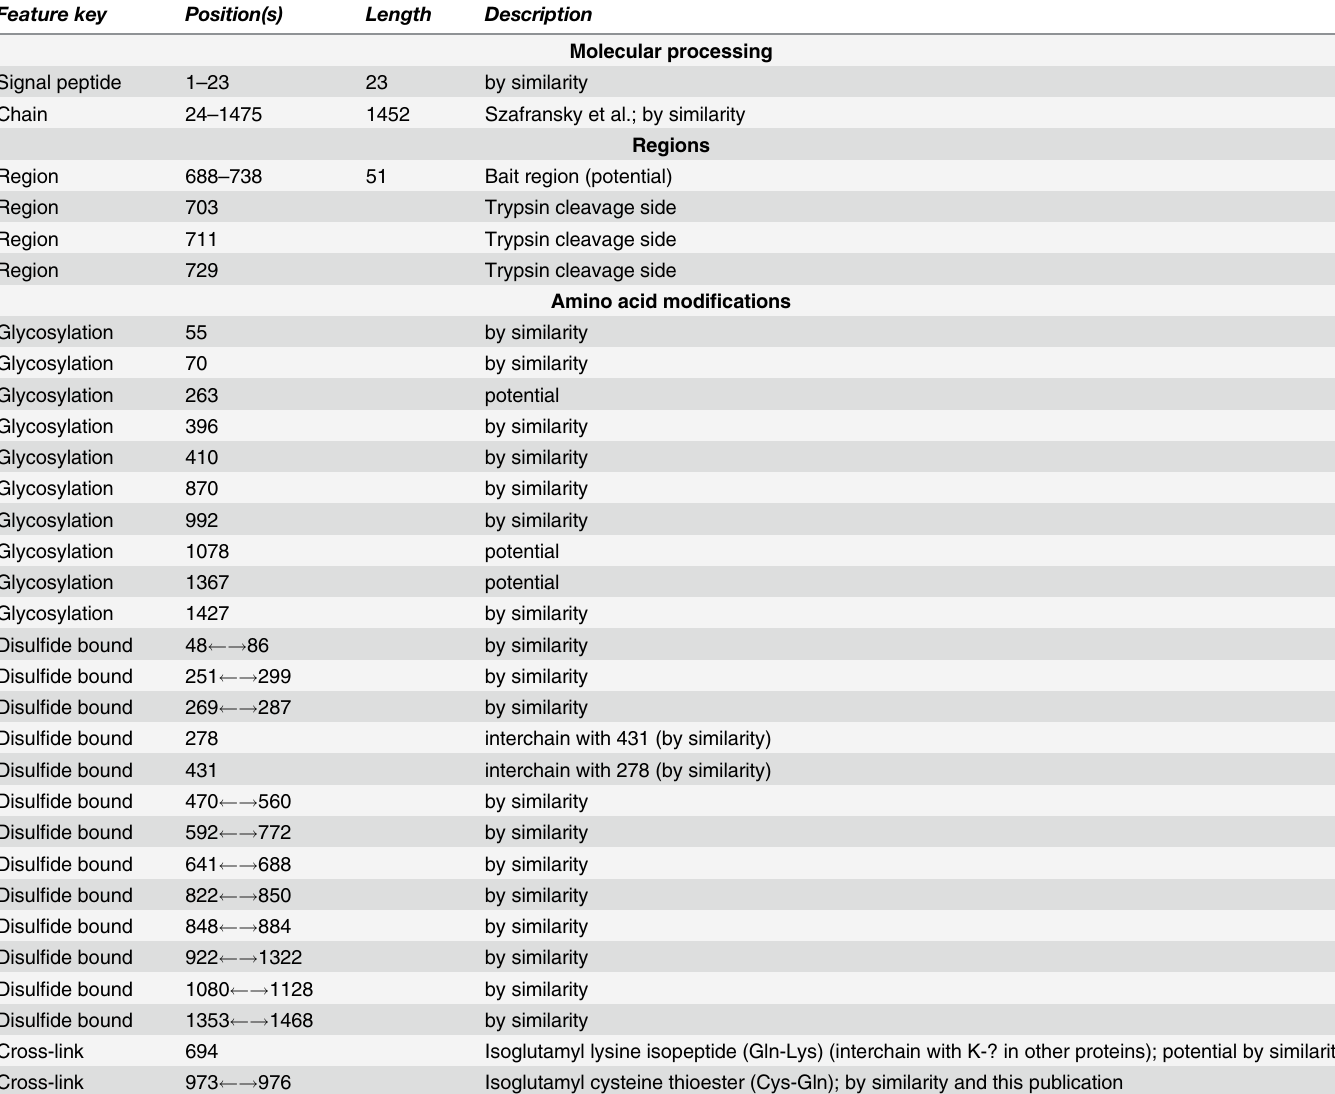
Table 2. Protein sequence features of A2M from Heterocephalus glaber